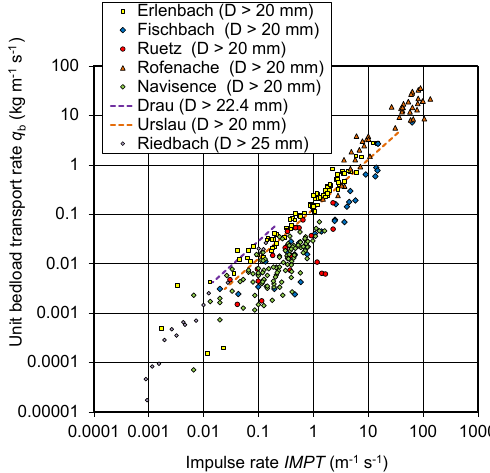
Figure 15. Comparison of geophone calibration data from eight different stream sites. Unit bedload transport rate q b for parti- cles with D larger than (mostly) 20mm is plotted against impulse rate IMPT. Data sources for additional data are as follows: Wyss et al. (2016c) for Navisence and Erlenbach (some data up to 2016 were added here); regression line from Habersack et al. (2017) for Drau; regression line from Kreisler et al. (2017) for Urslau (linear calibration relation is approximate; q b values given for D > 10mm were reduced by a factor of 0.68 to estimate q b values for D > 20mm; reduction factor was estimated from 85 samples of Erlen- bach moving basket data); Schneider et al. (2016) for